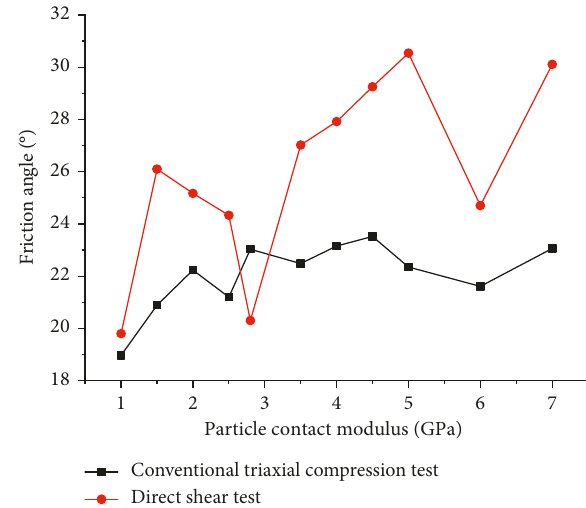
Figure 5: Influence of particle contact modulus on friction angle.